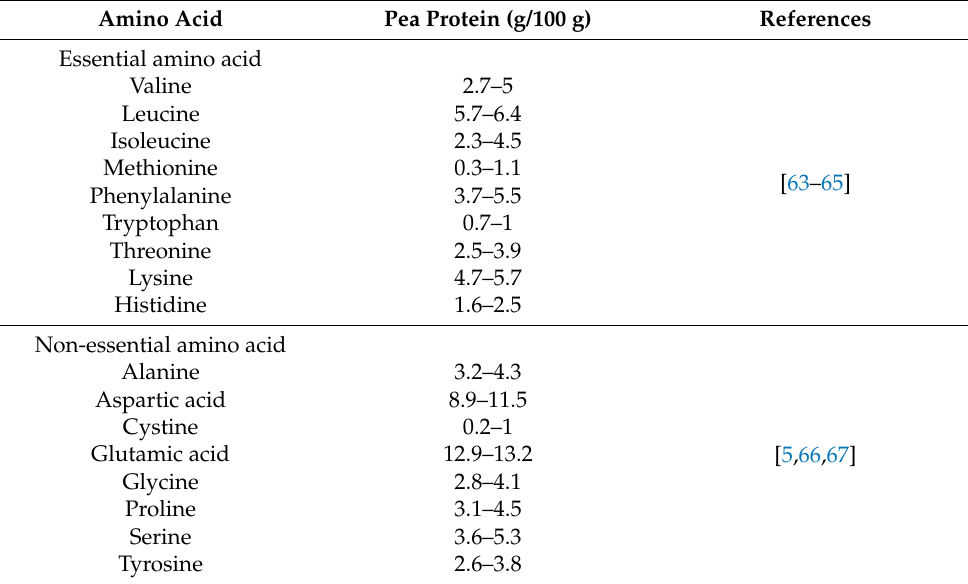
Table 2. Amino acid profiling of pea protein in g/100g. Amino Acid Pea Protein (g/100